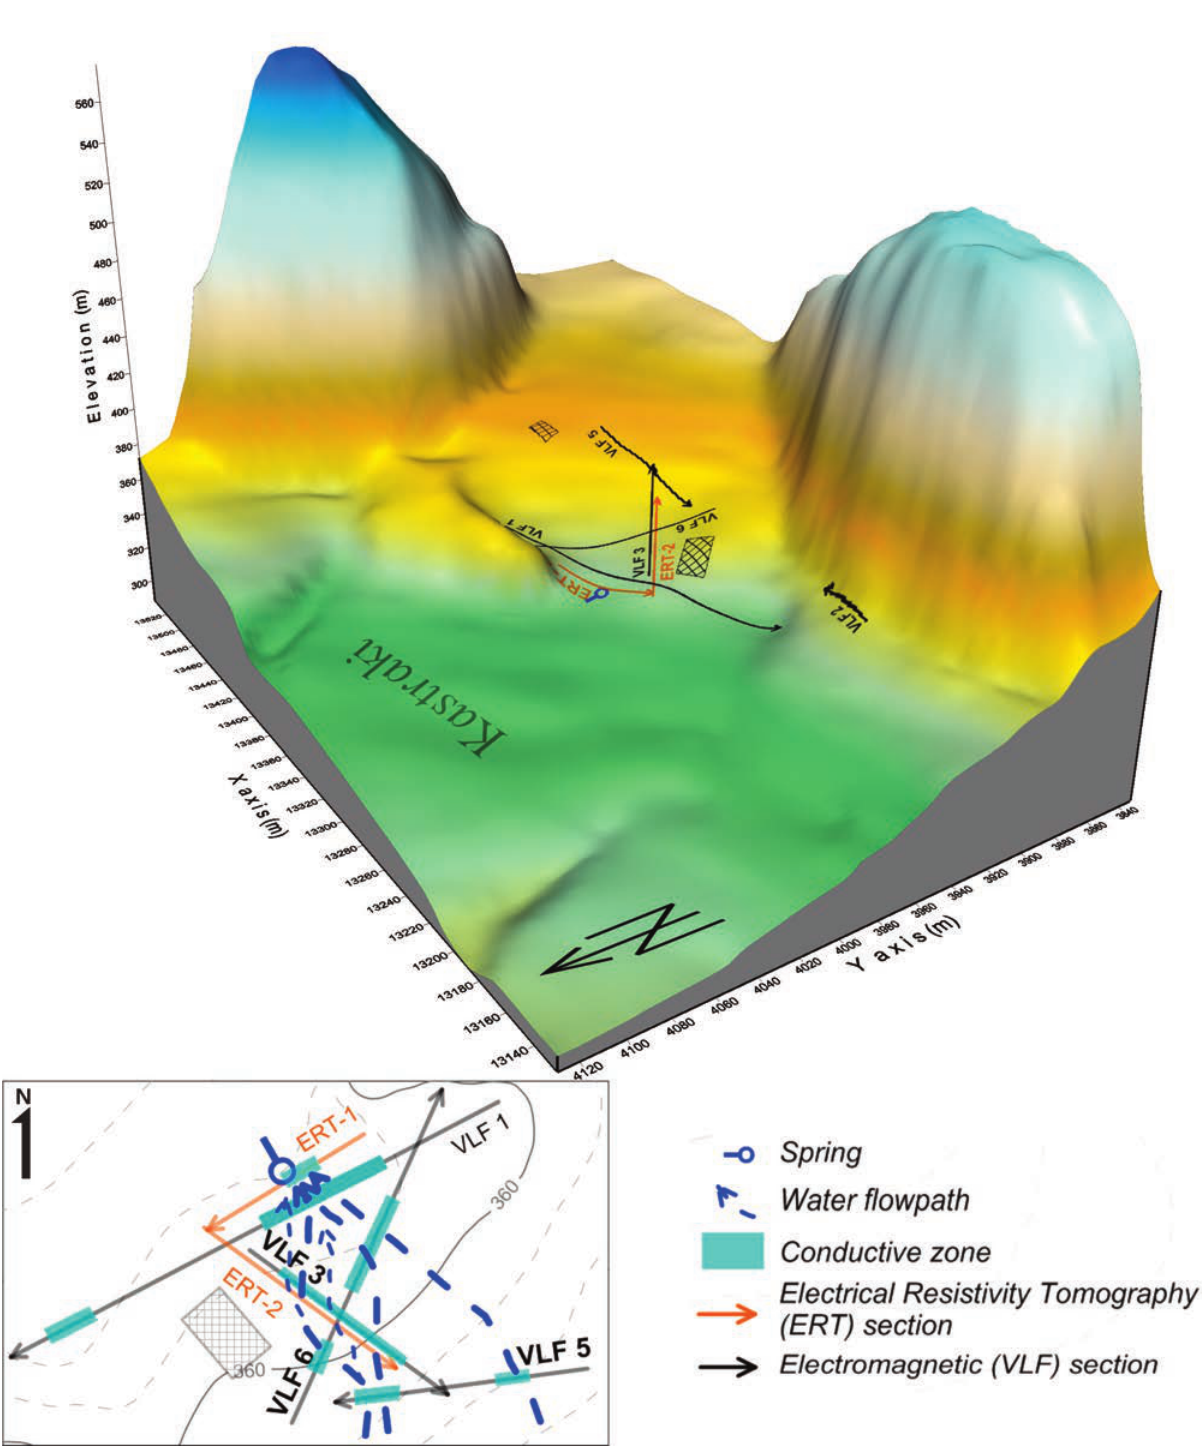
Figure 4. A 3-dimensional perspective representation of the study area on which the ERT and the VLF geophysical transverses are indicated. A 2-dimensional map of the same area along with the interpreted conductive zones and the groundwater flow paths is displayed